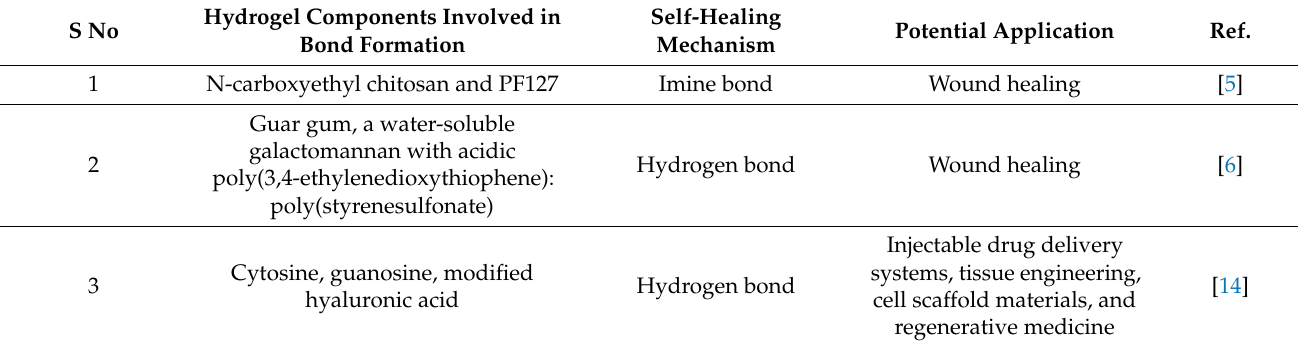
Self-Healing Potential Application Mechanism